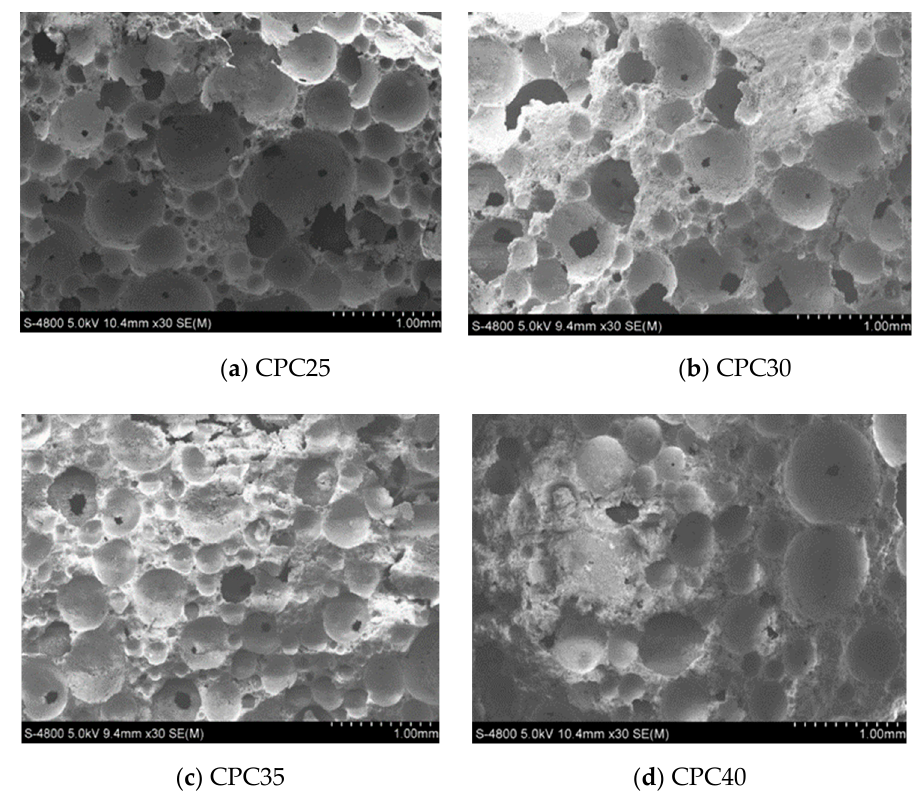
Figure 13. SEM images of pore structure of mixes with different coarse particle content: ( a ) CPC25; ( b ) CPC30; ( c ) CPC35; ( d ) CPC40.